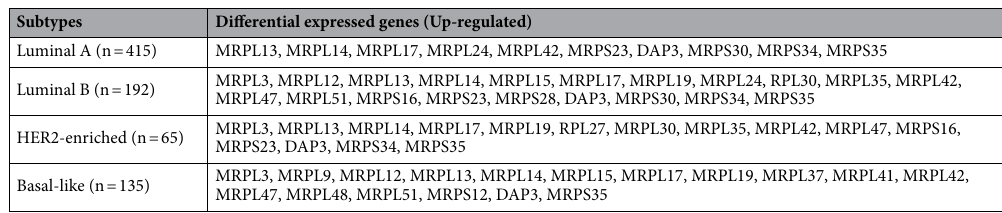
Table 1. Differential MRP gene expression in different breast cancer